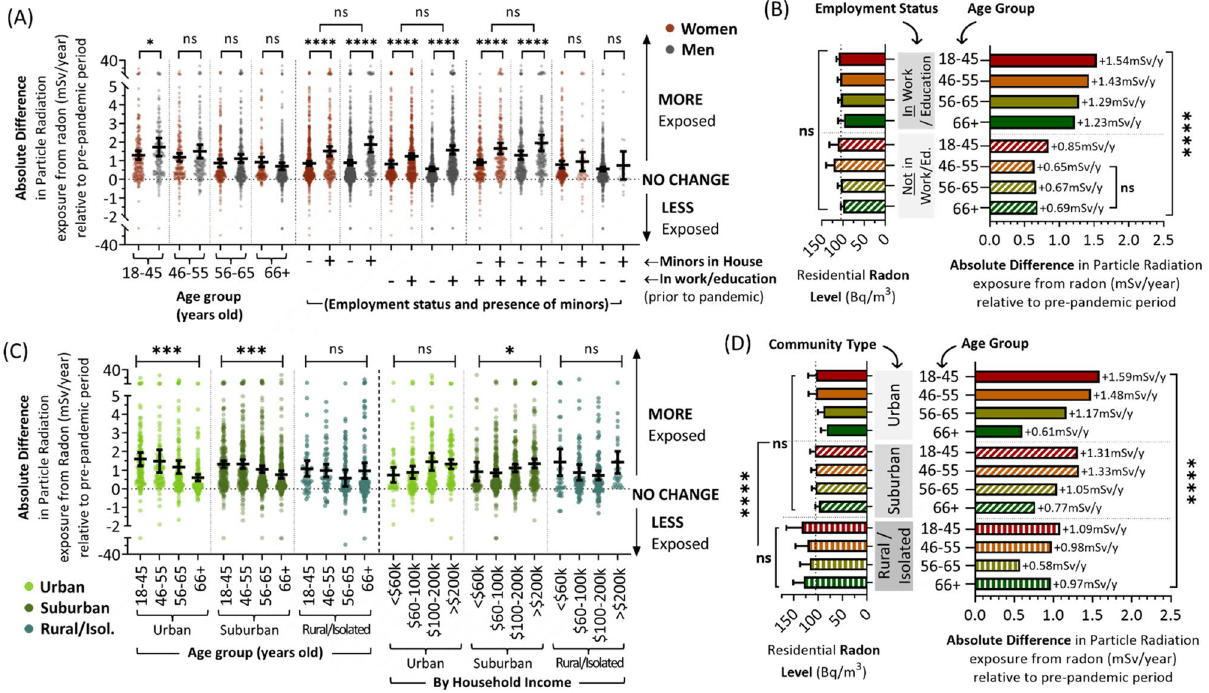
Figure 5. Increases in residential radon exposure after COVID-19 pandemic onset were greatest for those who are younger, have children at home, are in work, and/or live in urban or suburban areas. Panel A . The absolute difference in radiation dose rate (mSv/y) from residential radon relative to the pre-pandemic period being experienced by women (red) and men (grey), as a function of age, employment status and the presence of minors. Panel B . Combining employment status and age groups (from A), the absolute difference in radiation dose rate from radon (mSv/y), relative to residential radon level (Bq/m 3 ). Panel C . The absolute difference in radiation dose rate (mSv/y) from residential radon relative to the pre-pandemic period being experienced by people living in urban (light green), suburban (dark green), or rural/isolate areas (dark cyan) as a function of age or household income. Panel D . Combining community type and age groups (from C ), the absolute difference in radiation dose rate from radon (mSv/y), relative to residential radon level (Bq/m 3 ). For all data, pairwise statistical comparisons are Mann–Whitney tests, while larger demographic group comparisons are 1-way ANOVA. * p < 0.05, *** p < 0.001, **** p < 0.0001; ns = p > 0.05. Figures were prepared using Excel and GraphPad Prism 9.1.1 (225) (www. graph pad.